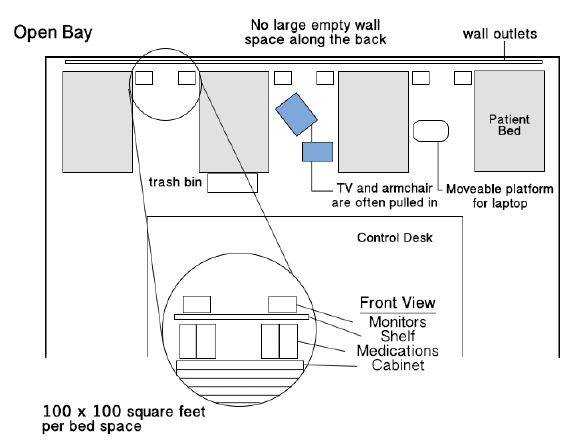
Fig. 5. The open bay at Midwestern Regional was approximately 100 sq. feet. With team sizes as large as 11 and the presence of equipment, it is challenging for clinicians to perform even basic duties, let alone maintain